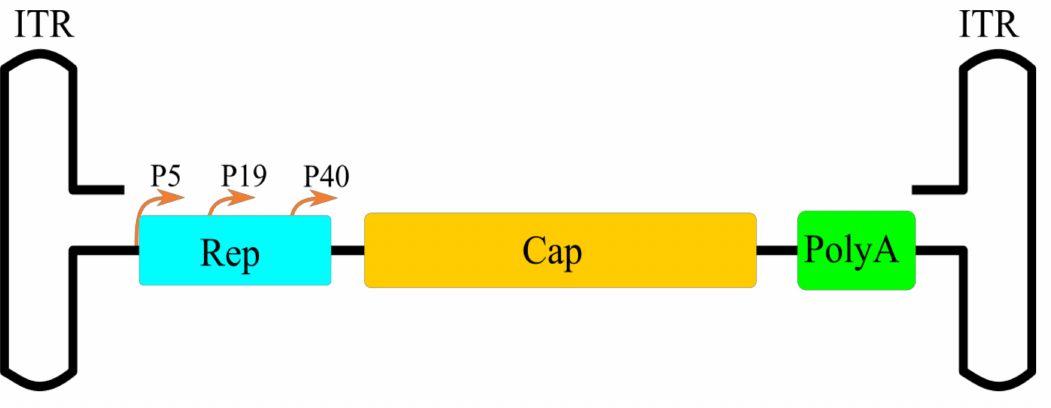
Figure 1. Schematic illustration of AAV